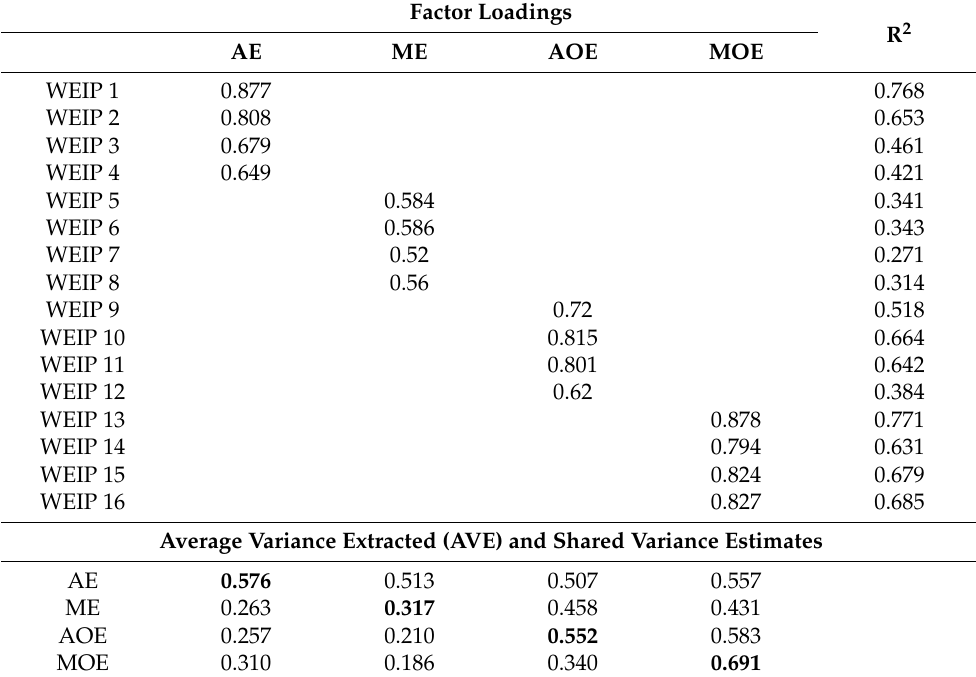
Table 4. Factor structure for WEIP-S